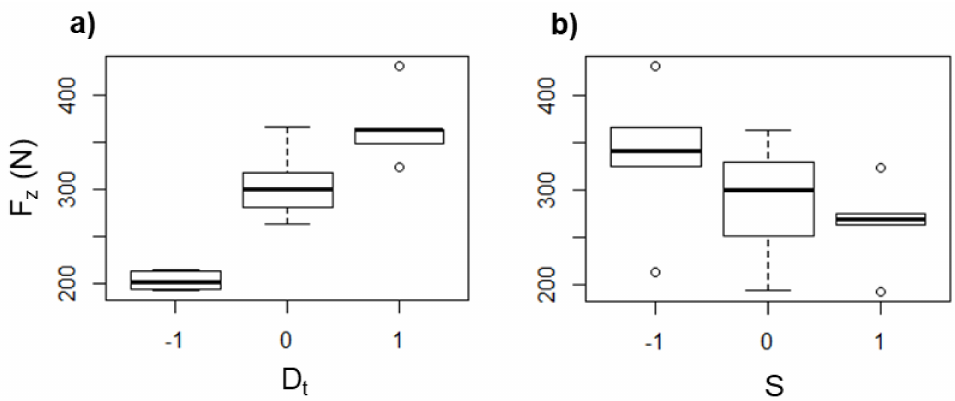
Figure 11. Box diagrams of F z (in N) for PCL as a function of ( a ) D t and ( b ) S .